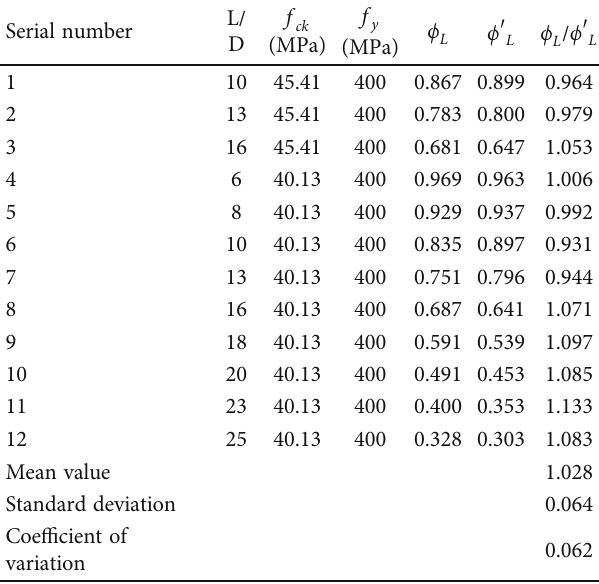
Table 7: Comparison of bearing capacity reduction factor calculated under axial compression with test and formula calculation